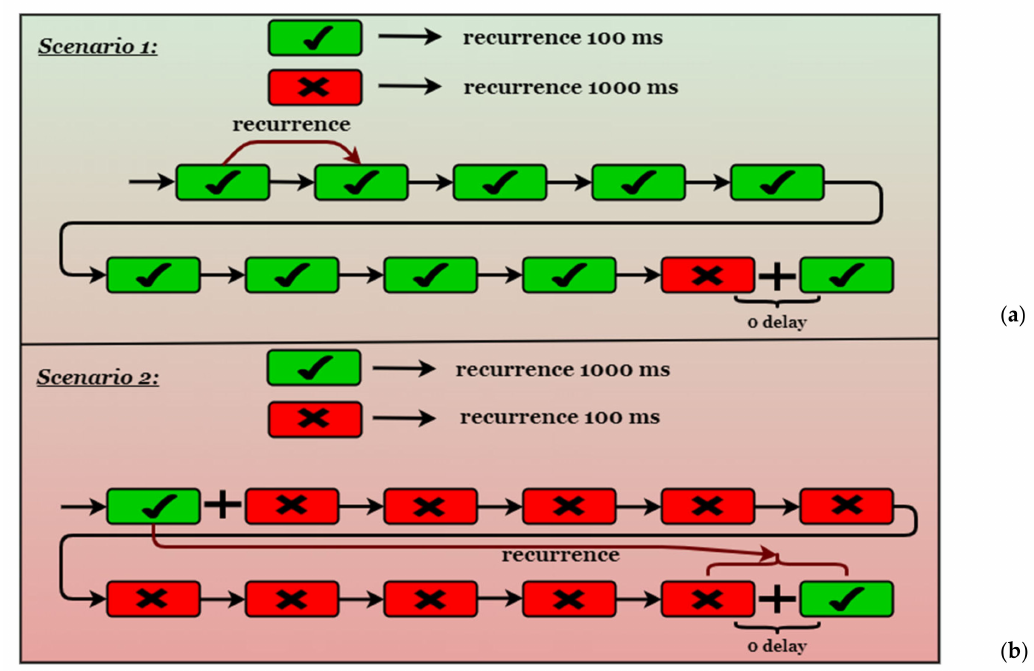
Figure 5. The 2 scenarios from the Subscriber Perspective regarding recurrence and validity of the messages. ( a ) Scenario 1–with high recurrence for valid messages. ( b ) Scenario 2–with low recurrence for valid